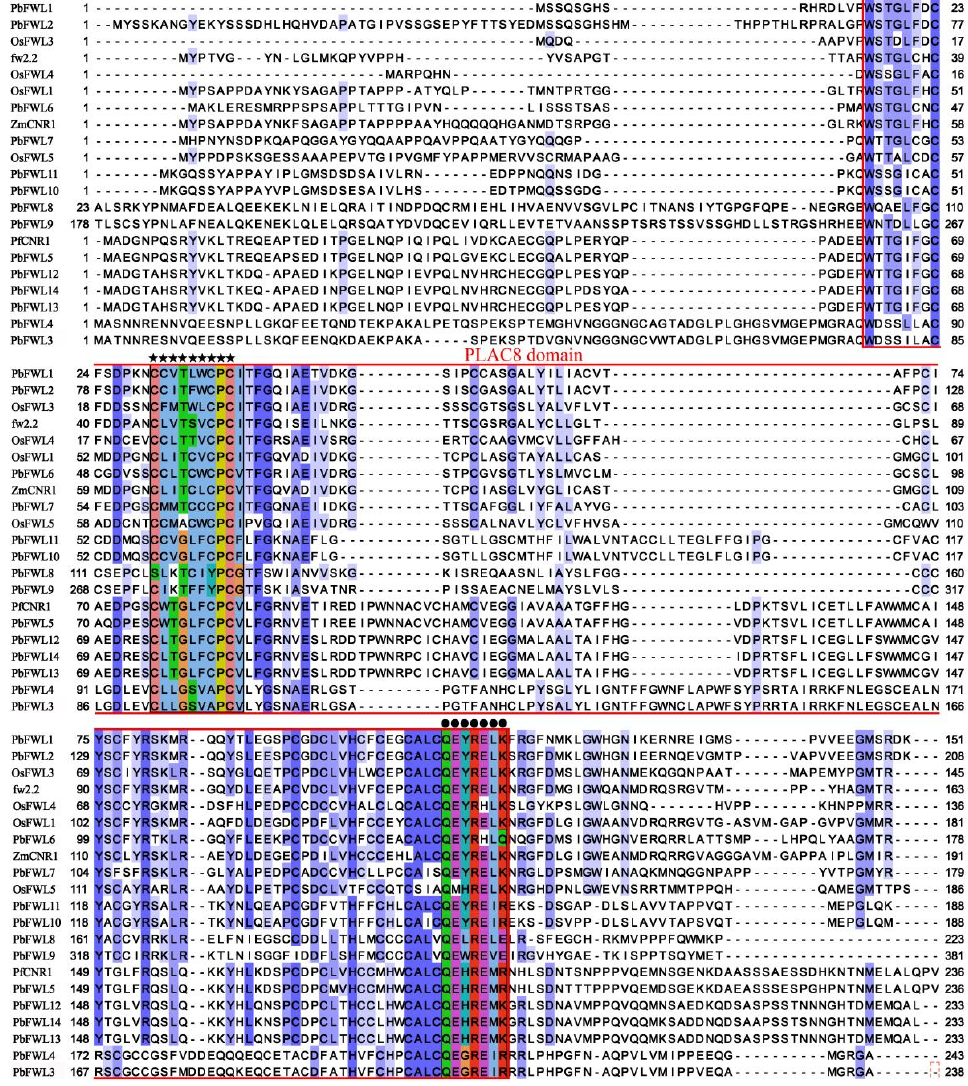
Figure 1. Multiple sequence alignment of PbFWLs, ZmCNR1, OsFWL1, OsFWL3, OsFWL4, OsFWL5, PfCNR1, and fw2.2. Identical and similar amino acids are shown in light blue and blue, respectively. The PLAC8 structure domain is indicated by the red box. The conserved motifs CXXXXXCPC and QEYRELK are indicated by black five-pointed stars and filled circles.